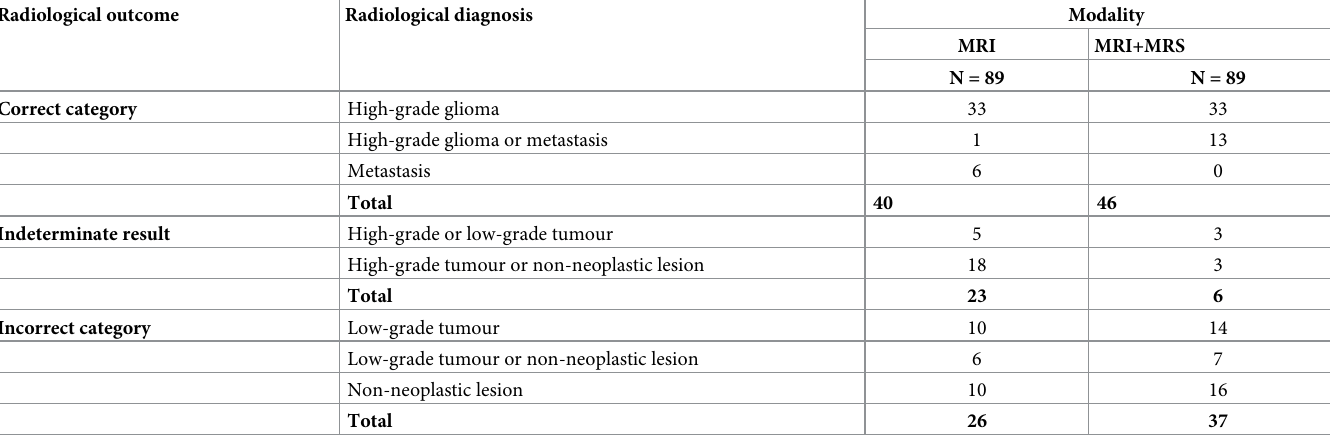
Table 6. Distribution of radiological diagnoses to diagnostic categories in cases with a confirmed primary high-grade CNS tumour. Radiological